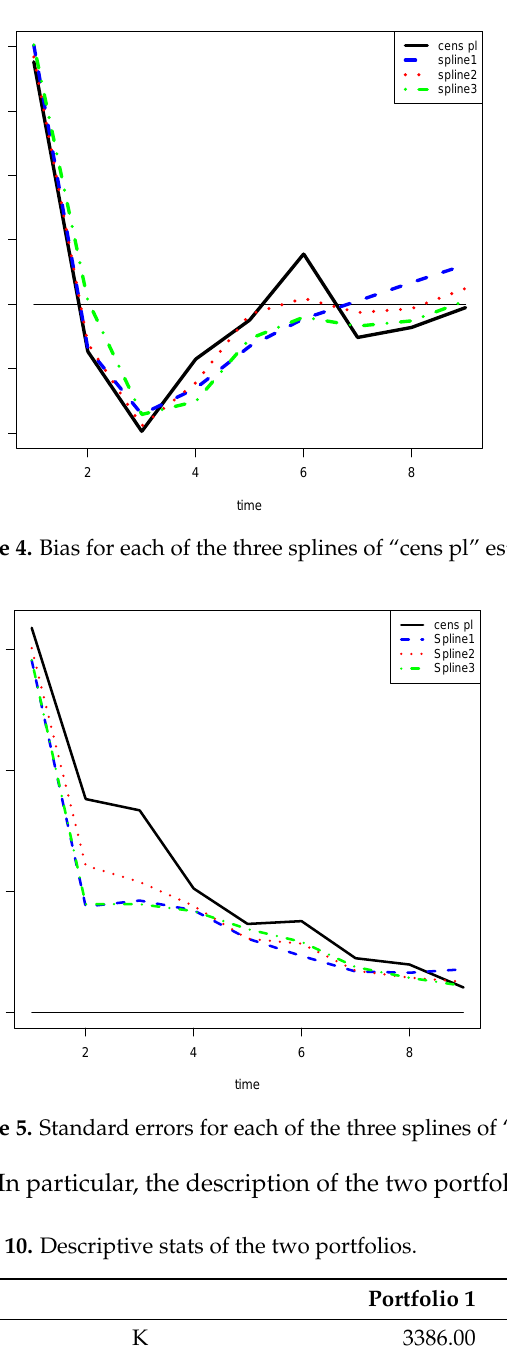
Figure 5. Standard errors for each of the three splines of “cens pl” estimators.